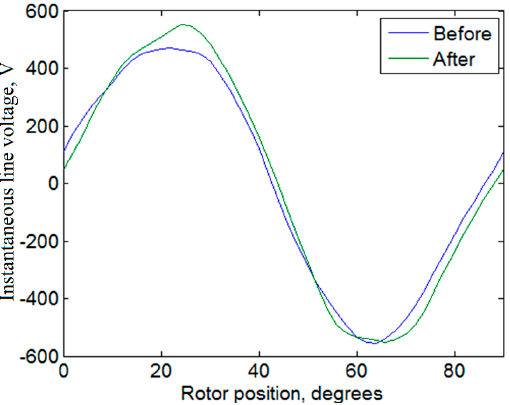
Figure 11. Comparison of line voltage waveforms of the three-phase FRMs at rated torque.